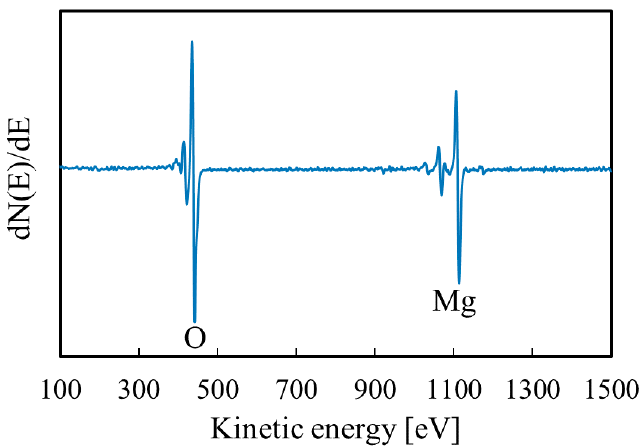
Figure 7. AES spectra of the Mg(OH) 2 film.